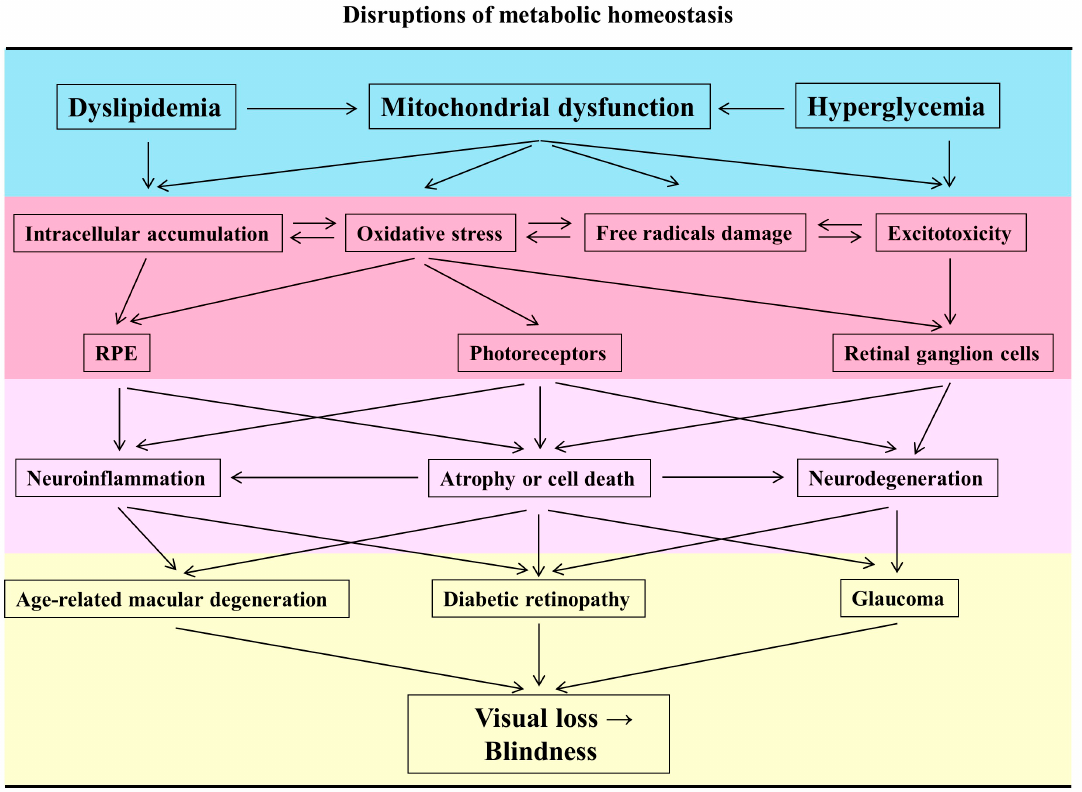
Figure 1. Different pathogenetic mechanisms lead to ocular diseases. Arrow indicates pleiotropic factors, as described above, and how they interact with the retinal cells that contribute to eye diseases.